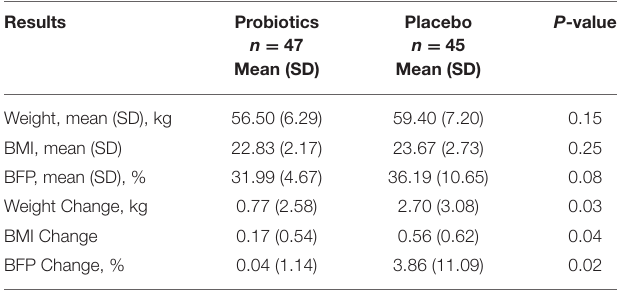
TABLE 2 | The status of body weight, BMI, and BFP of participants enrolled over